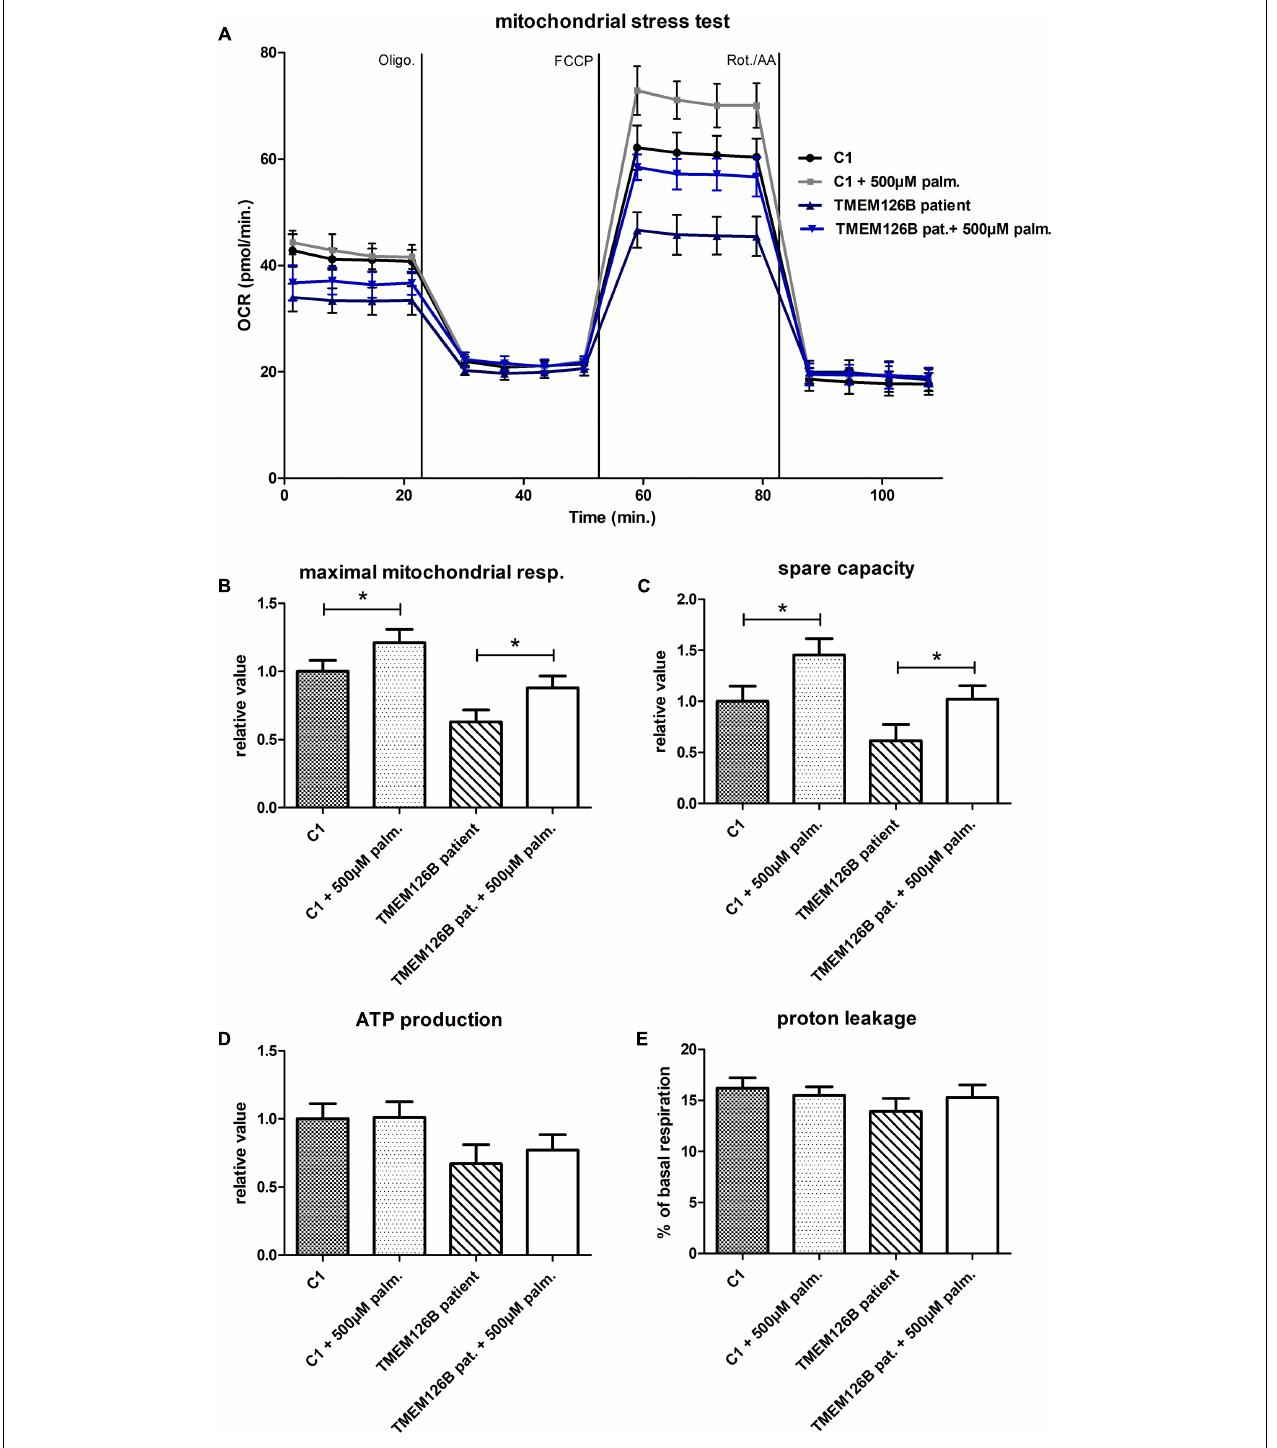
FIGURE 2 | Mitochondrial stress test in TMEM126B patient fibroblasts. (A) Oxygen consumption rates (pMoles/min) measured in patient and healthy control fibroblasts (C1) after 16 h treatment with 500 µ M palmitic acid. (B) Maximal respiratory capacity in both control and patient fibroblasts increased with 21 and 25%, respectively, upon treatment with palmitic acid, where respiration in the TMEM126B patient restored from 63 to 88% of the control level. (C) The measured increase in maximal respiration resulted in a 45 and 67% increase in respiratory spare capacity in control and patient cells, respectively. (D) ATP production in patient fibroblasts was 63% of the untreated control level and was not significantly altered by palmitic acid treatment. (E) Also proton leakage was not significantly changed, where basal respiration due to non-coupled ATP production was never higher than 17%. ∗ Statistically significant.